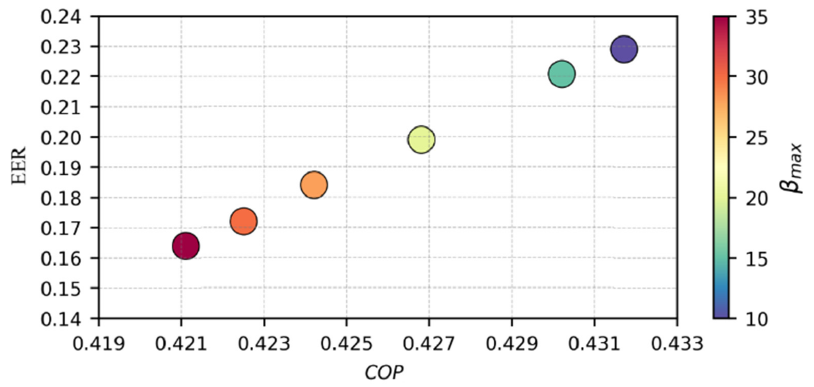
Figure 6. The x and y axes of the 3D bubble chart represent COP and EER , respectively, while color